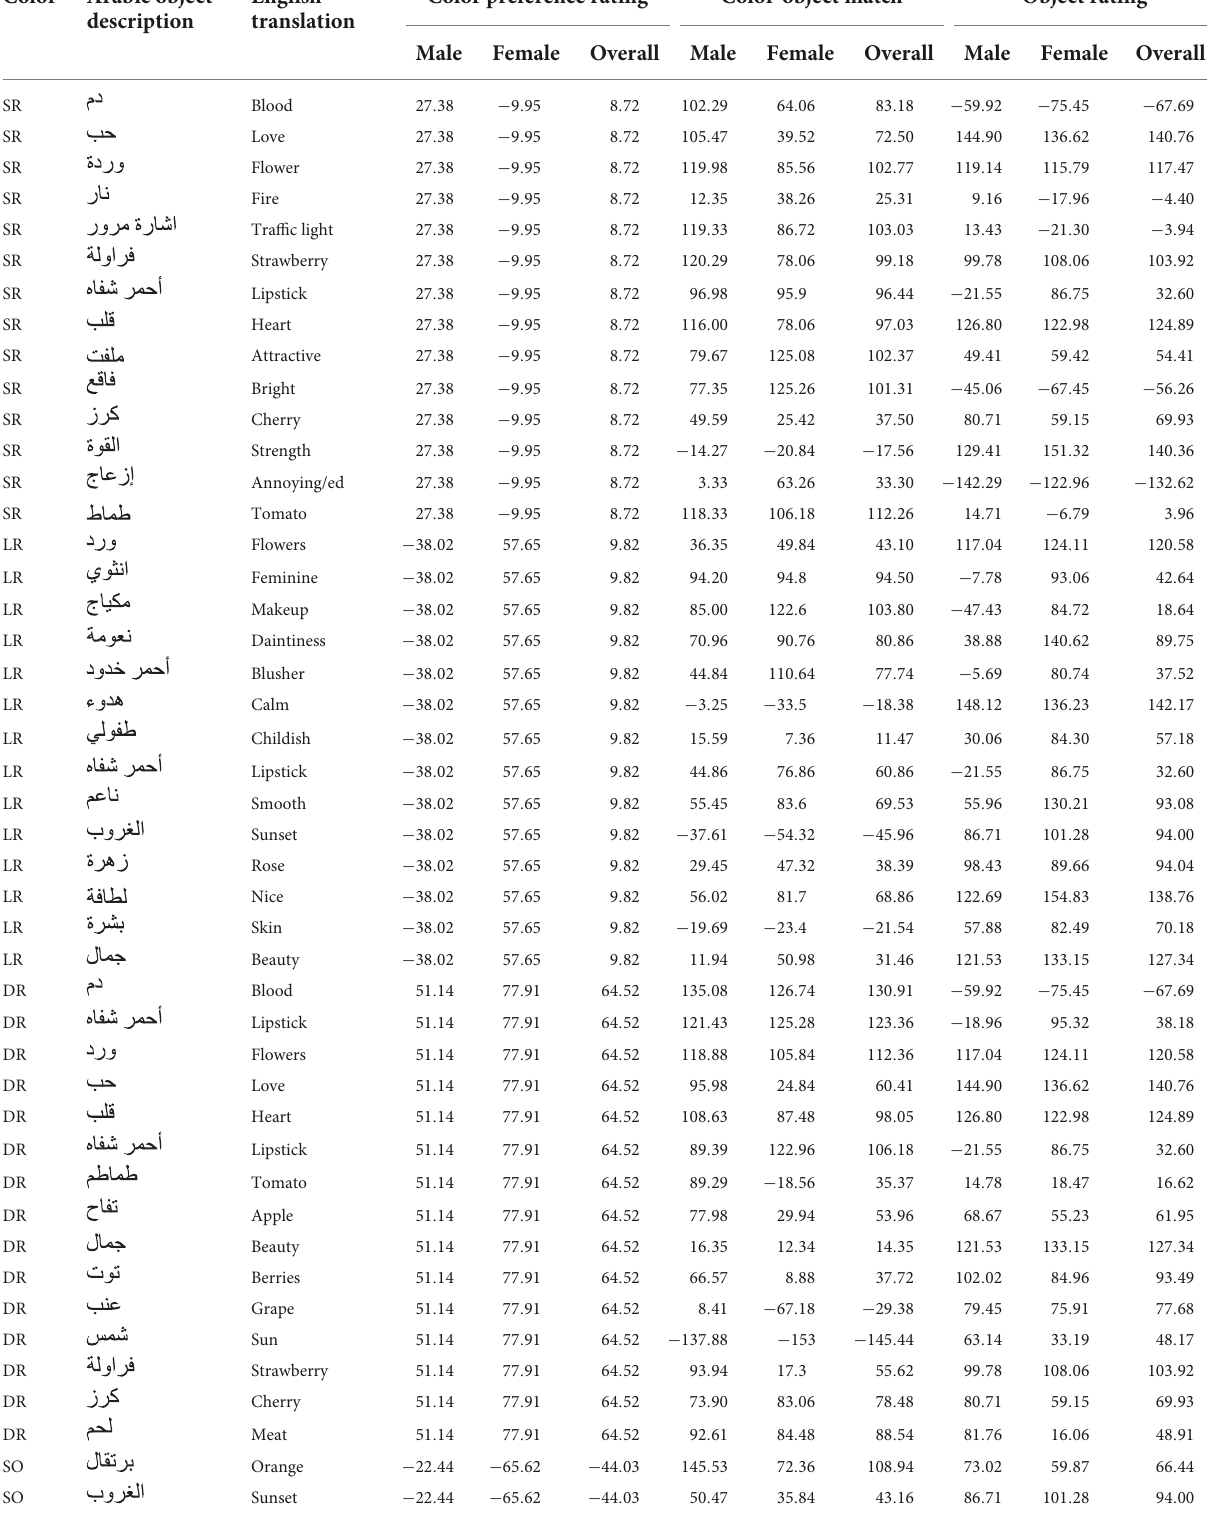
TABLE 2 For each color, the associated Arabic objects, the English translated, the average color preference rating, the average match between the color and its associated objects, and the average valence for the objects, for male, female, and overall. Color Arabic object English description